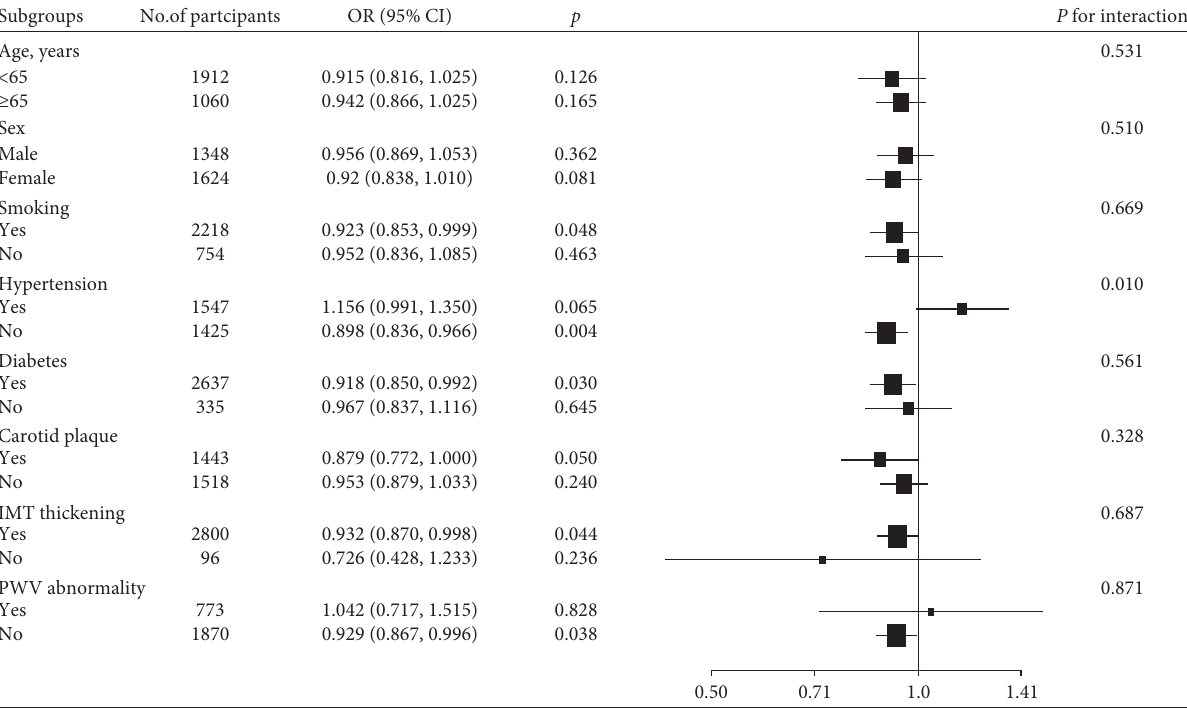
Figure 1: Subgroup analysis of WCE and